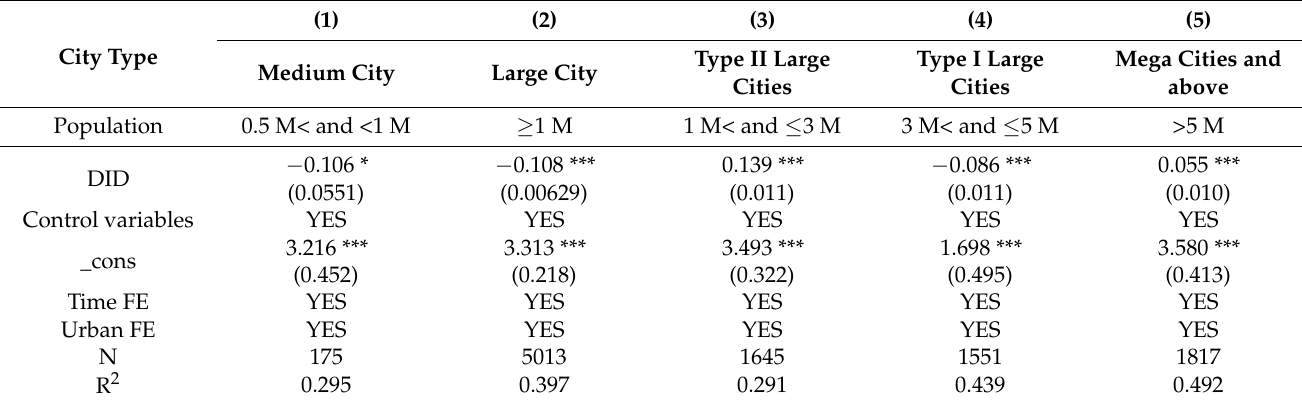
Table 4. Heterogeneity analysis of urban population